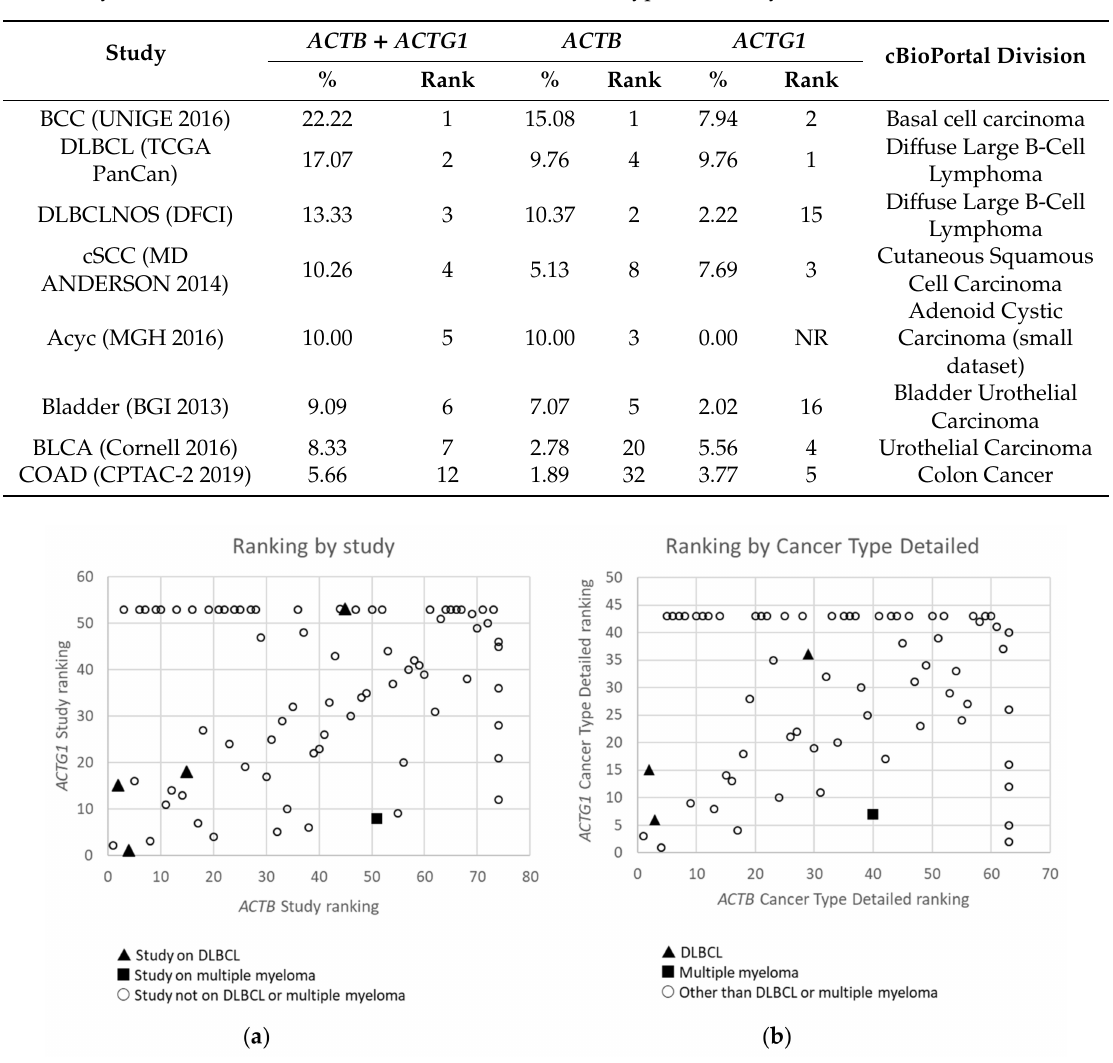
Figure 2. Ranking of Studies ( n = 79) ( a ) and Cancer Types Detailed ( n = 68) ( b ) based on frequency of mutations in ACTB versus these in ACTG1 in cBioPortal. Studies or detailed cancer types in which neither mutations in ACTB nor ACTG1 were found are not included. Studies or detailed cancer types in which mutations were found for ACTB , but not for ACTG1 and which therefore did not receive a rank for ACTG1 , or vice versa, have received an ‘artificial max high constant rank number’ to be able to include them in the graphs (i.e rank number set to 53 for ACTG1 or 74 for ACTB in ( a ) and 43 for ACTG1 and 63 for ACTB in ( b )). Data derived from the Cancer Types Summary